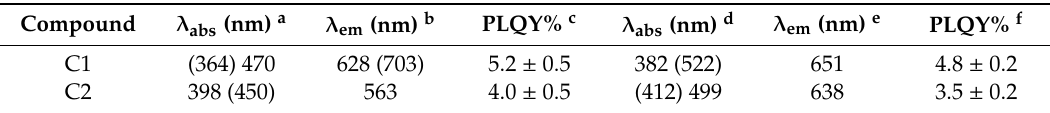
Table 1. Optical data for C1 and C2 recorded in solution and as crystalline neat compounds. PLQY—photoluminescence quantum yield.